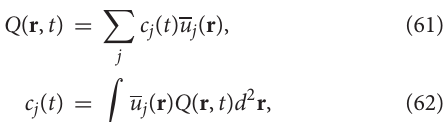
0.1, 0, 0.1. (B) The power of each covariance mode −